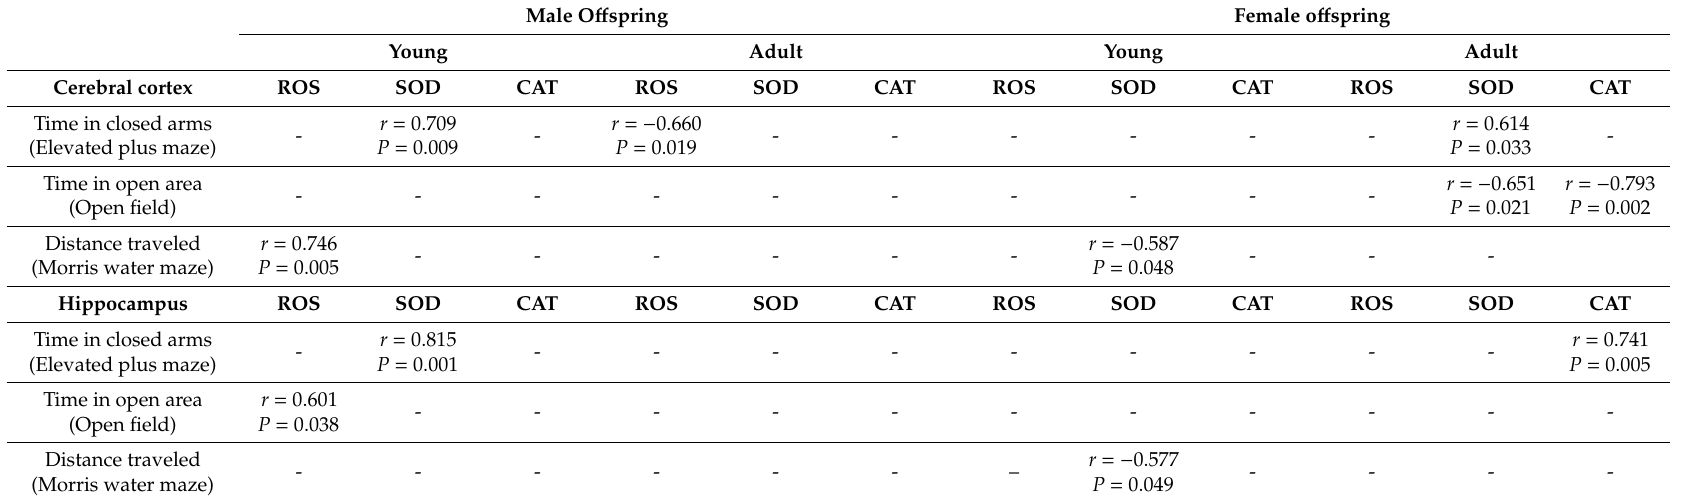
Table 5. Pearson correlation between behavior parameters and oxidative stress